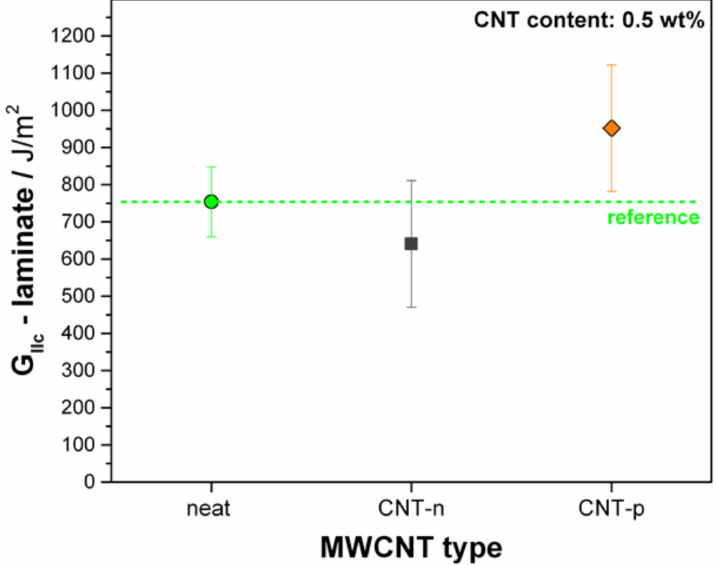
Figure 9. G IIc of neat and 0.5 wt.% MWCNT-modified UD prepreg